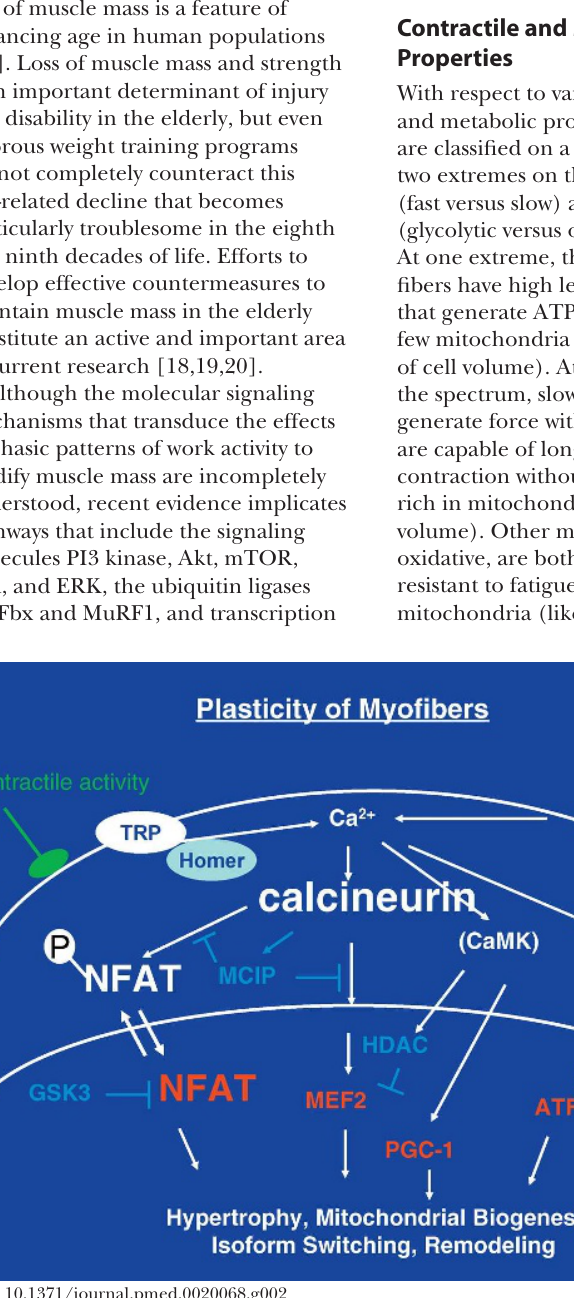
Figure 2. Molecular Signaling Pathways Link Changes in Contractile Activity to Changes in Gene Expression That Establish Myofi ber Diversity A tonic pattern of motor nerve activity promotes changes in intracellular calcium that trigger a variety of intracellular events that modify the function of nuclear transcription factors. The pathway transduced by calcineurin and NFAT is highlighted in larger type. Other signals are received by cell surface receptors to activate similar or parallel signaling events. Signaling proteins that participate in transducing effects of contractile activity to specifi c genes include ion channels (TRP), scaffolding proteins (Homer), protein phosphatases and protein kinases (calcineurin, CAMK, p38MAPK), DNA-binding transcription factors (shown in red; NFAT, MEF2, PGC-1, ATF2), and endogenous inhibitors (shown in blue; GSK3, HDAC, and MCIP) (inhibitors antagonize gene activation via the pathways indicated, in some cases acting as negative feedback